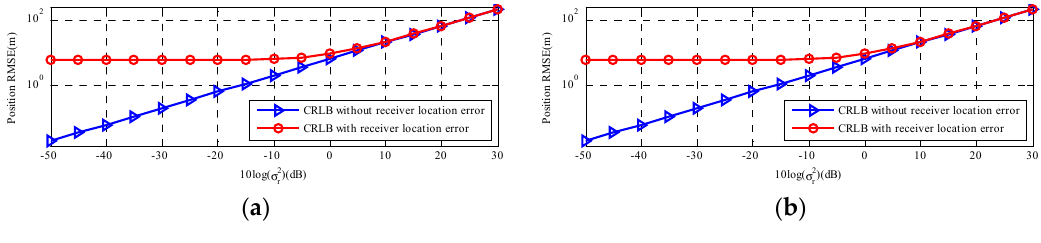
σ . ( a ) The near-field stationary source; ( b ) r